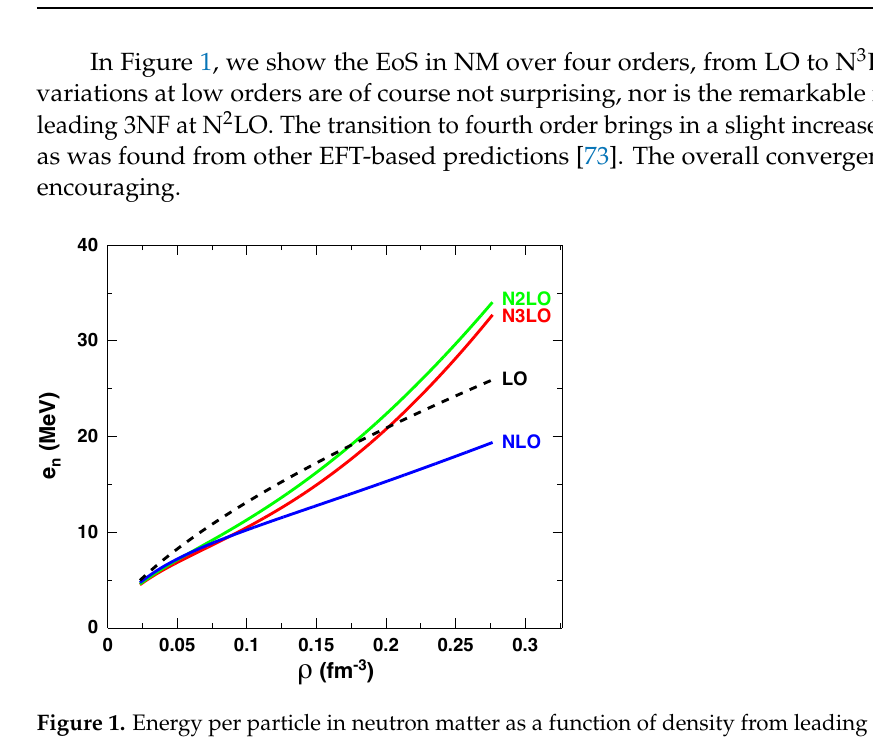
Figure 1. Energy per particle in neutron matter as a function of density from leading to fourth order of chiral perturbation theory. The cutoff is fixed at 450 MeV. The EoS are those obtained in Ref. [6]. In Figure 2, an analogous presentation is provided for SNM. Similar considerations apply with regards to the order-by-order convergence pattern and the 3NF “signature” as in